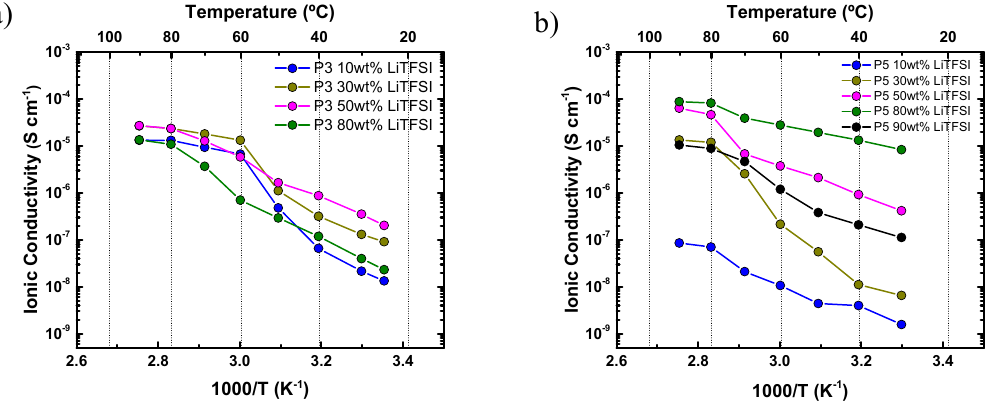
Figure 5. Ionic conductivity of SPE-P3 ( a ) and SPE-P5 ( b ) with different amounts of LiTFSI.